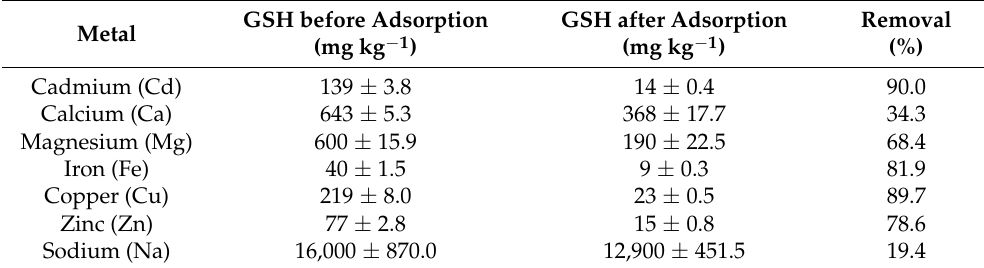
Table 4. The mineral profile (mg kg − 1 ) of GSH samples from batch 2 (20.97 mg L − 1 ) before and after the cadmium adsorption in fixed-bed columns connected in series . The experimental conditions were a pH of 6.2, a flow rate of 140 mL min − 1 , and a temperature of 55 ◦ C. The results are expressed as the dry weight and are the average of three